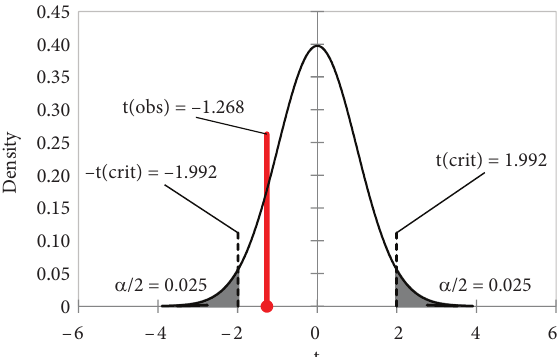
Fig. 15. Student’s Distribution for Two-tailed test, significance level